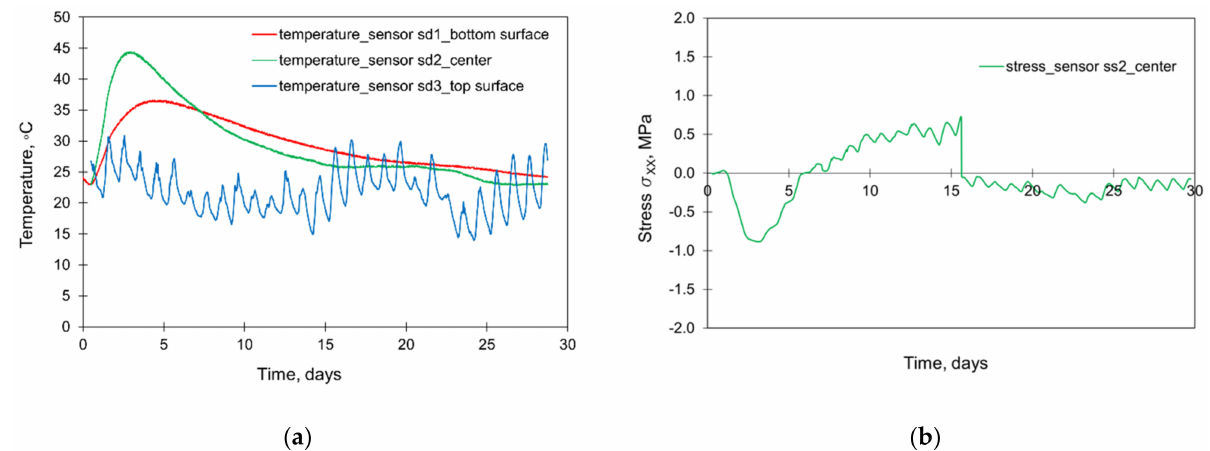
Figure 3. The results from the thermal ( a ) and stress ( b ) sensors